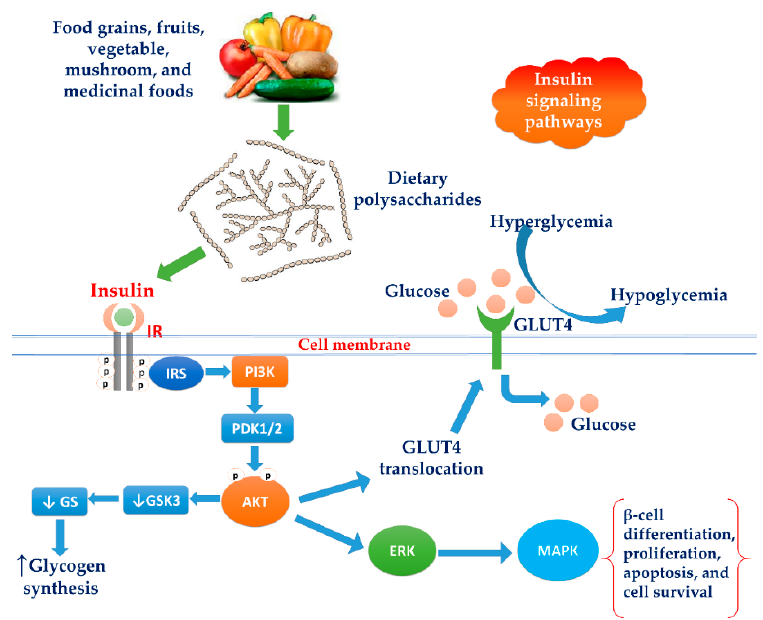
Figure 2. Schematic representation of the action of dietary polysaccharides on the insulin signaling pathway. Dietary polysaccharides elevate the cascade signaling of IRS / PI3K / AKT / GLUT4 and inhibit GSK3 / GS, eventually stimulating the synthesis of glycogen. Akt is a main mediator to activate ERK / MAPK pathways and stimulate various physiological and biochemical mechanisms, including cell di ff erentiation, proliferation, apoptosis, and cell endurance. IRS: insulin receptor substrate, PI3K: phosphoinositide 3-kinase, PDK1 / 2: Phosphoinositide-dependent protein kinase 1 and 2, AKT: serine / threonine-specific protein kinase, GSK-3: glycogen synthase kinase-3, GS: glycogen synthase, GLUT4: glucose transporter type 4, ERK: extracellular-signal-regulated kinase, MAPK: mitogen-activated protein